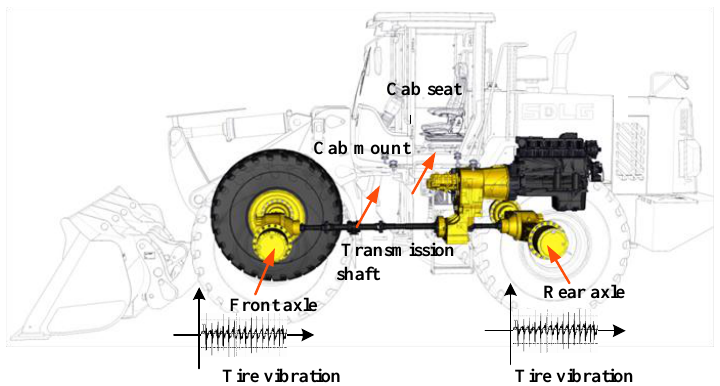
Figure 5. Transmission path analysis.